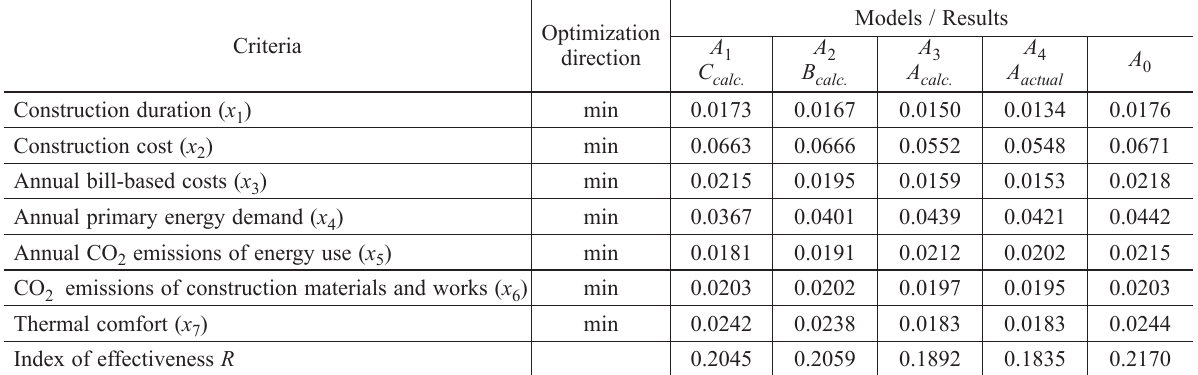
Table 3. A weighted–normalized decision making matrix for method ARAS with final results